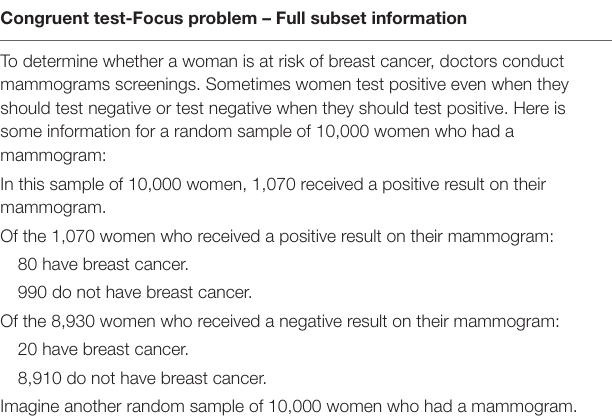
FIGURE 1 | Experiment 1a condition accuracy means while controlling for numeracy. Error bars represent ± 1